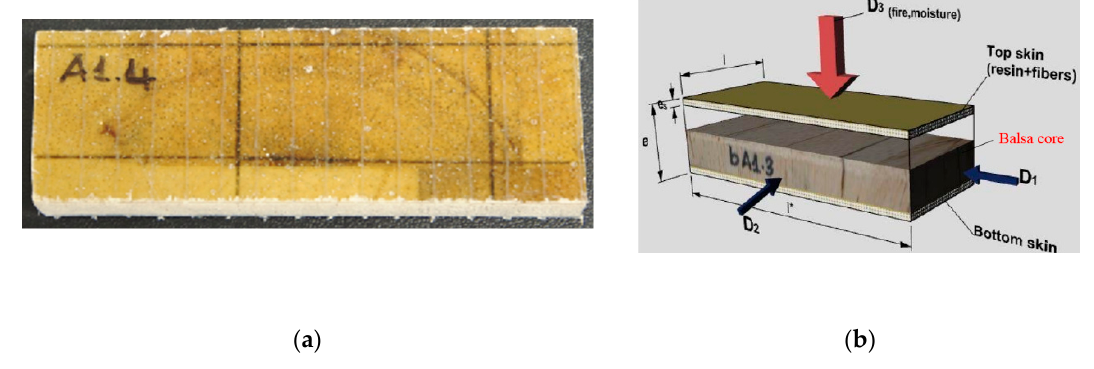
Figure 1. The studied E-glass/polyester/balsa sandwich composite beam specimen ( a ). Dimensions were illustrated the chosen directions of the moisture and heat flux. D 1 , D 2 and D 3 are, respectively, the transverse directions and the thickness direction ( b ).